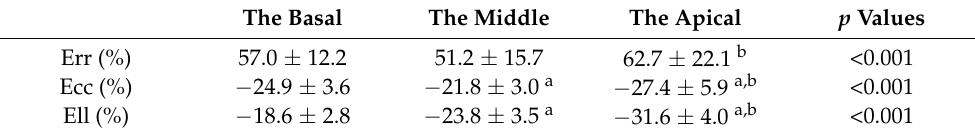
Table 2. Myocardial strain in different parts of the left ventricle. The Basal The Middle The Apical